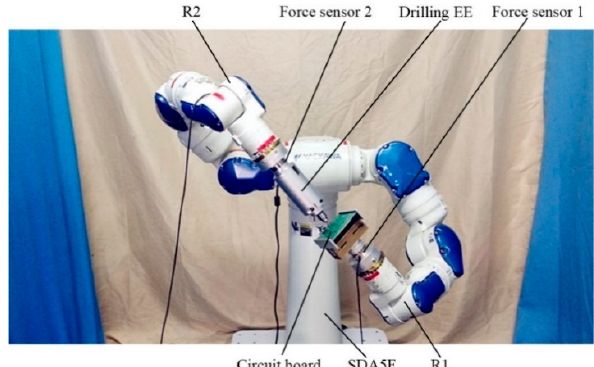
Figure 6. The drilling operation. EE: end-effector.